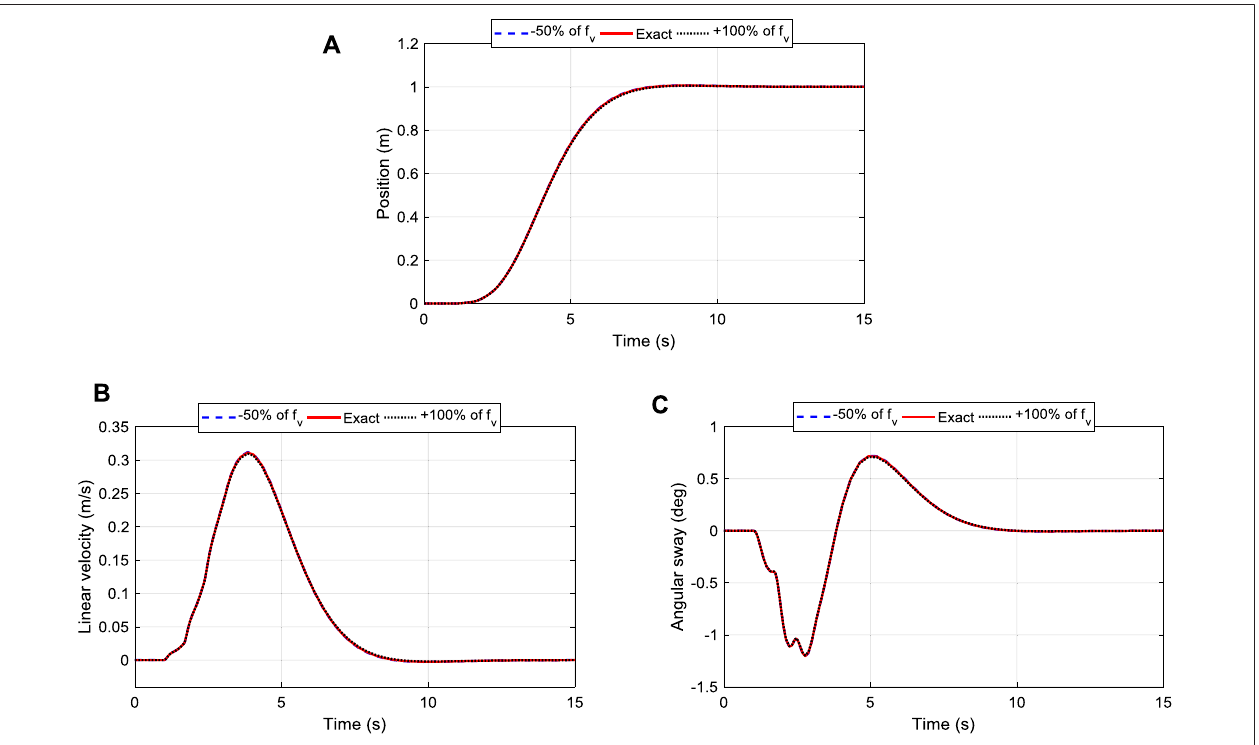
FIGURE10| Robustness ofiTDC+PPCschemetochangesoffriction coef fi cient: (A) PositionTracking; (B) LinearVelocityoftheroller; (C) Oscillation/sway angle control of the